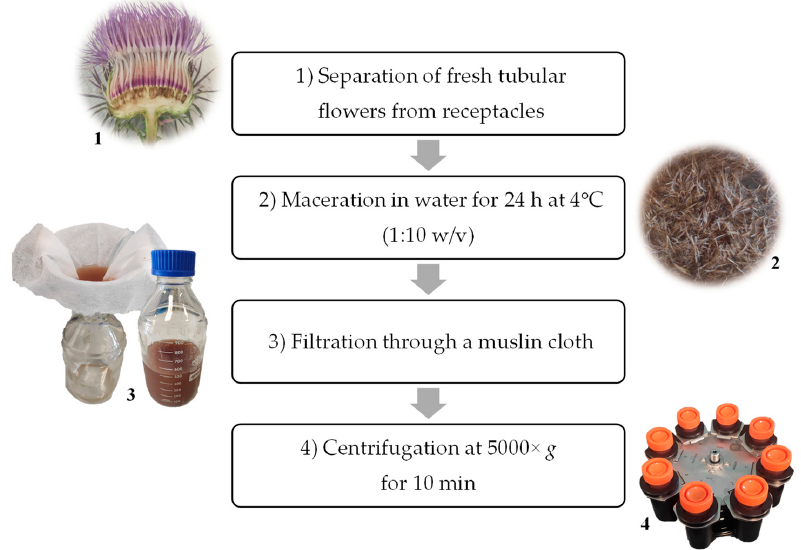
Figure 1. Flow chart illustrating the followed steps for the preparation of crude extracts (CE) from Onopordum tauricum Willd. flowers heads.